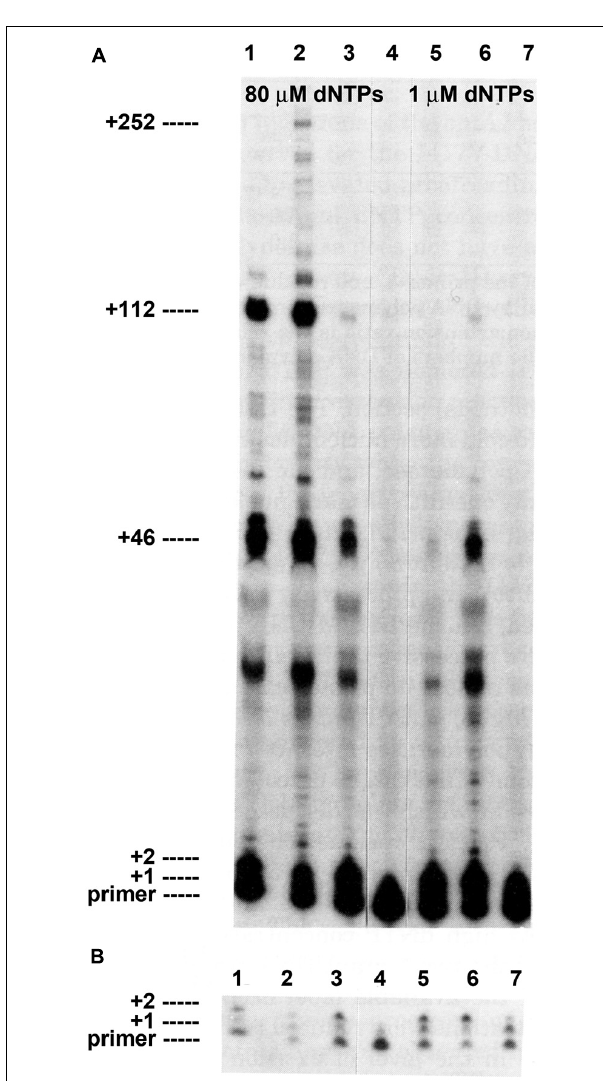
FIGURE 1 | Intrinsic processivity of bacteriophageT4 wild type and mutant DNA polymerases. Primer elongation was determined in the presence of a heparin trap as described (see Materials and Methods). Reaction products were separated under denaturing gel electrophoresis conditions. (A) Almost no primer extension was detected if heparin was added before the DNA polymerase in the control reaction, lane